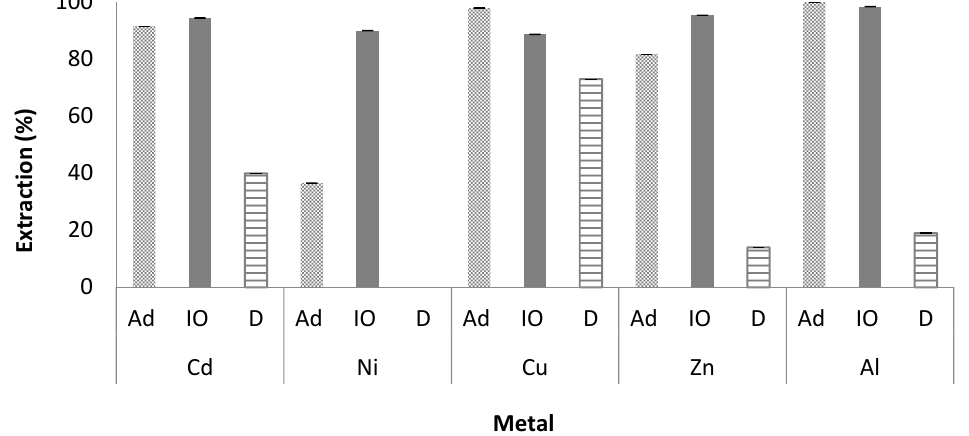
Figure 3. Metal extraction efficiency depending on sorbents used ( n = 5); Solid sorbents: Ad, Adsorbsia As 600; IO, Iontosorb Oxin; and D, Duolite GT-73